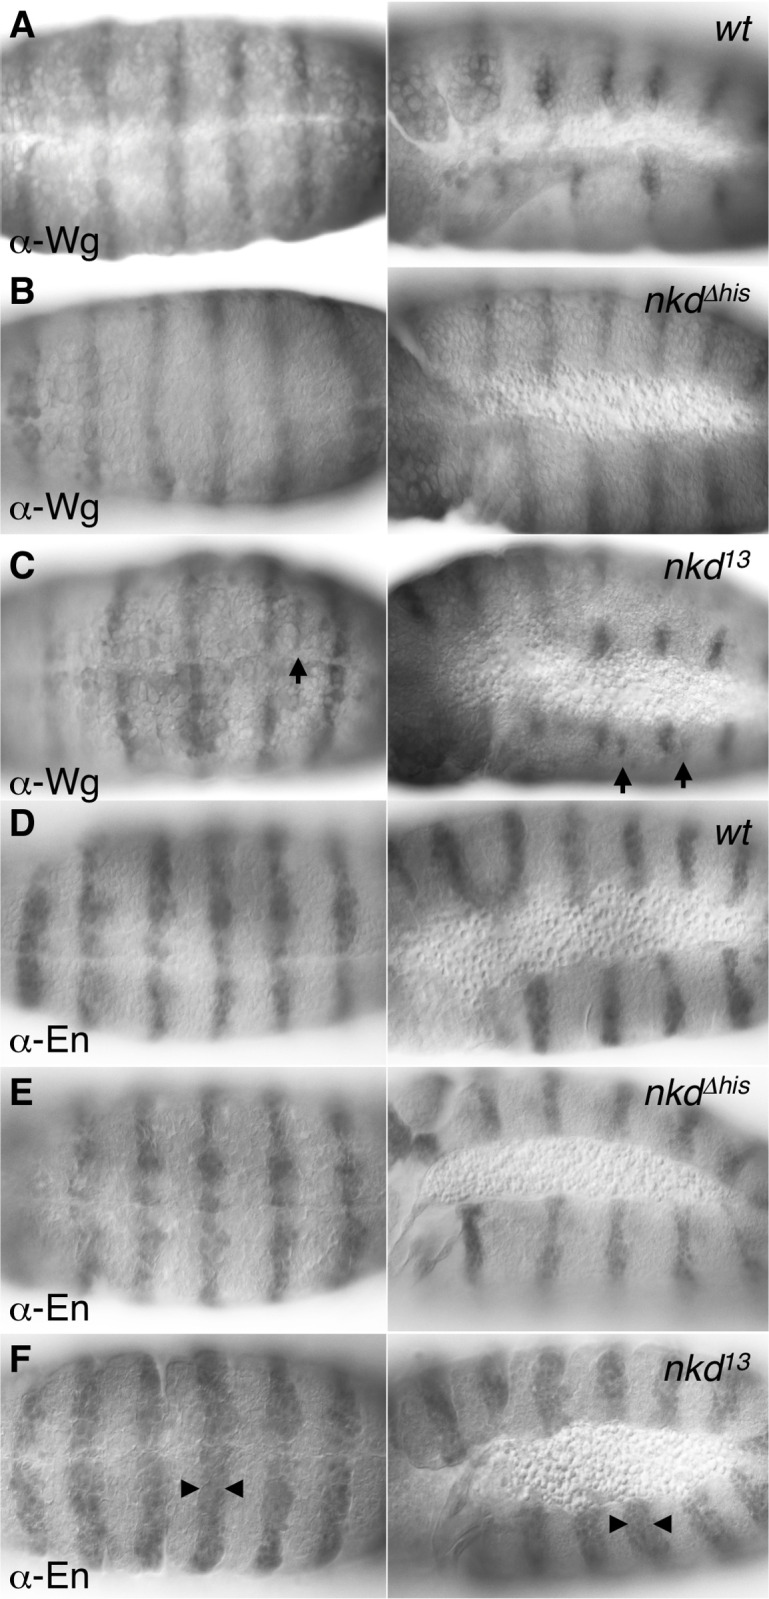
Ectopic Engrailed and Wingless expression in nkd mutant Drosophila embryos.5–6 hr old wt and nkd mutant embryos, as indicated in panels, stained for Wingless (Wg, A–C) or engrailed (En, D–F) expression; left, ventral view; right, side view. nkd null (nkd13) but not ΔHisC mutants (nkdΔhis) exhibit an expansion of En expression (arrowheads) in every segment, and sporadic patches of ectopic Wg expression (arrows). The latter appear to correlate with the sporadic regions of excess Naked cuticle shown in main Figure 6D,E, and thus likely accounts for the partially ‘Naked’ phenotype of these embryos.